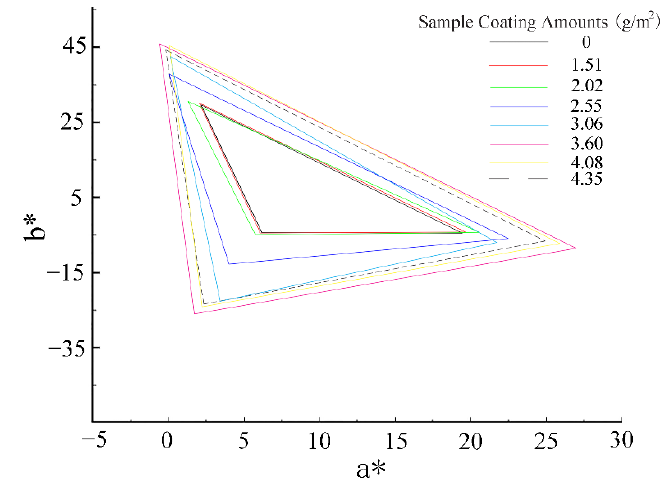
Figure 20. Color gamut of paper samples with different coating amounts.